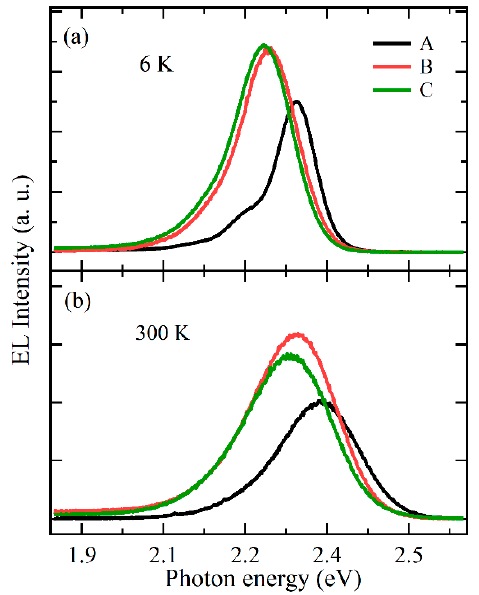
Figure 3. EL spectra of samples A, B, and C measured at 6 K ( a ) and 300 K ( b ) at 2 mA.